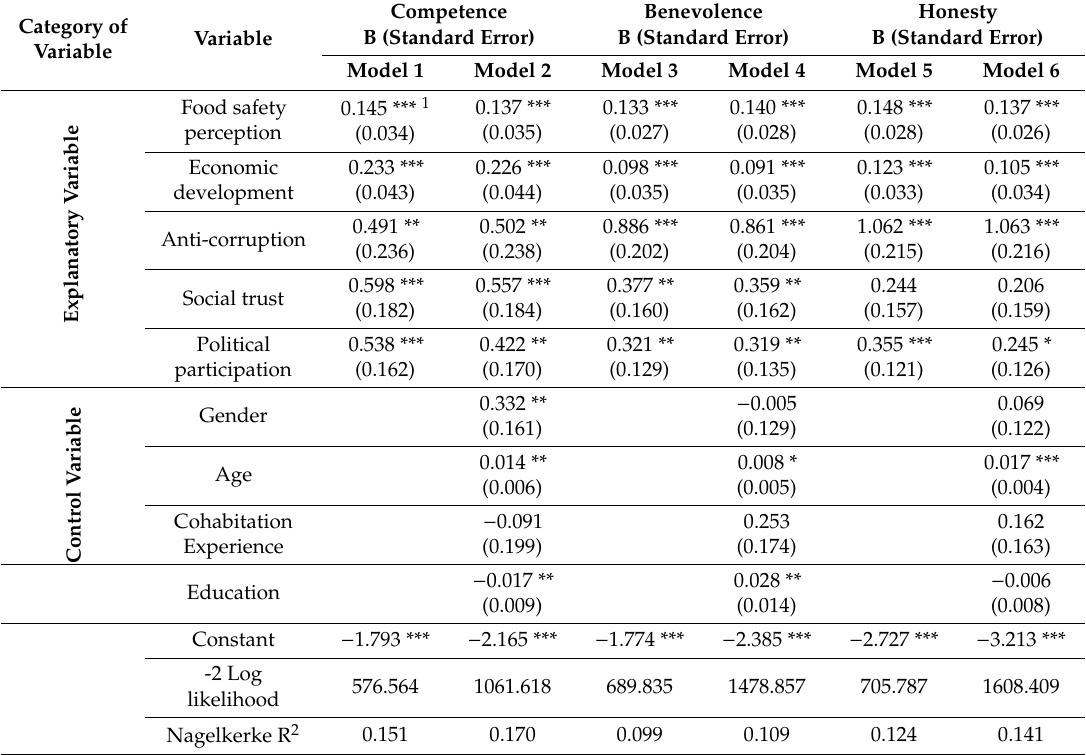
Table 2. Logistic regression results for each dimension of governmental trust.